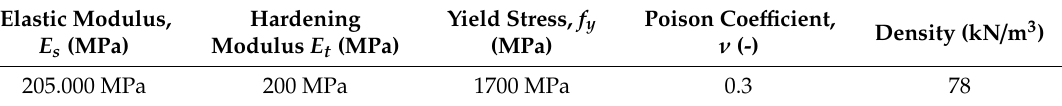
Figure 11. Stress–strain relationship for steel material. Table 4. Material properties of steel in the numerical model.